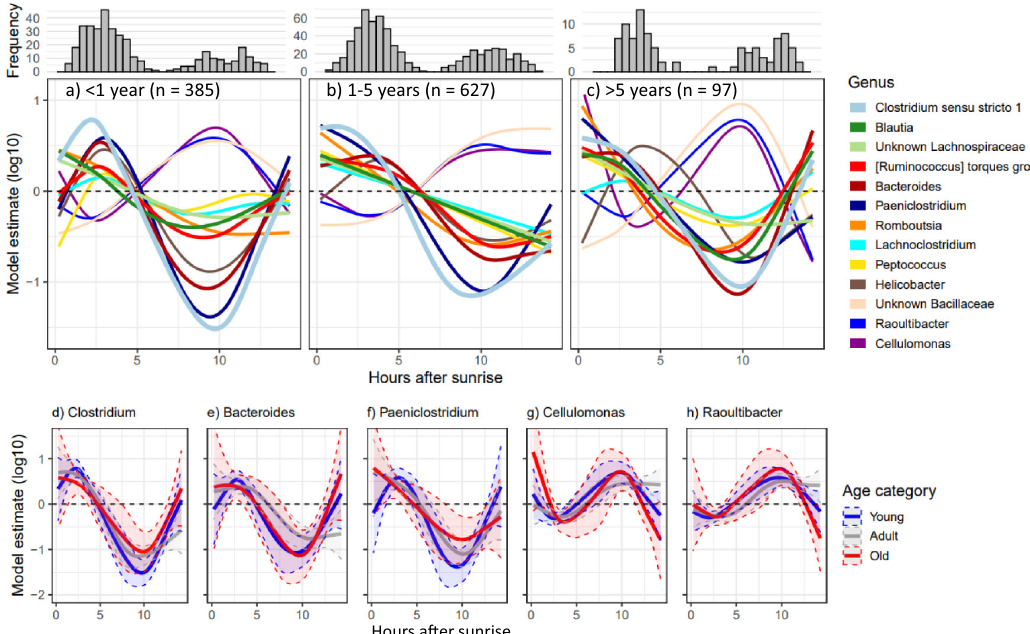
Fig. 6 Diurnal oscillations do not decay with age. a – c Diurnal oscillations of 16 focus genera in a) young meerkats (<1 year old; n = 385). b adult meerkats (1 – 5 years old; n = 627); and ( c ) particularly old meerkats (>5 years old; n = 97). Zero represents the taxa mean and sample distributions are indicated by the histograms. d – h Model estimates and 95% con fi dence intervals for ( d ) Clostridium (sensu stricto 1) ; ( e ) Bacteroides ; ( f ) Paeniclostridium , ( g ) Cellulomonas , and ( h ) Raoultibacter , split by age category (blue = young; grey = adult; red = old). Source data are provided in the source data fi